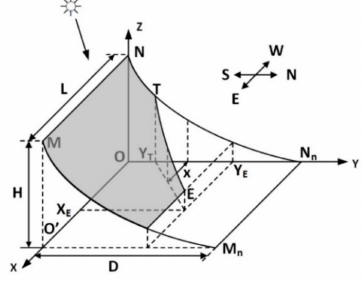
For F x / F y ≥ L / D corresponds to case (iii). Case (i) is shown in Figure 3 indicating the shaded area in grey and the exposed area to sun’s rays is in white.